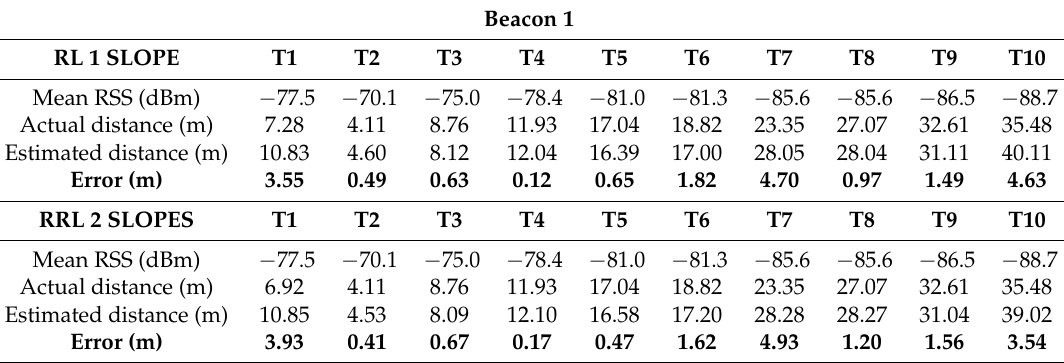
Table 9. Estimation of distances of 10 target points from beacon 1 by means of the signal attenuation model with 1 and 2 regression